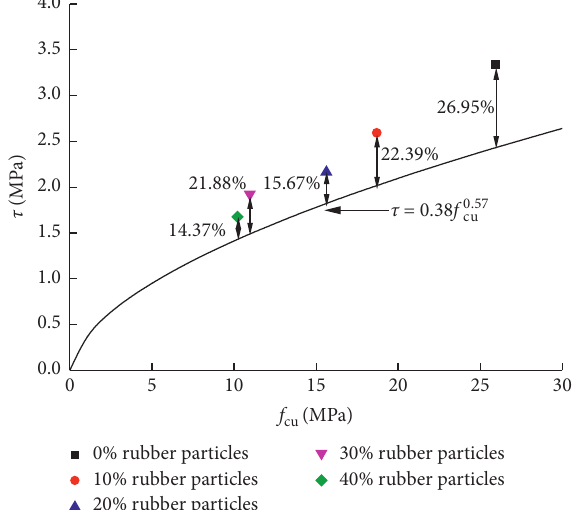
Figure 12: Relationship equation between the compressive strength and shear strength of concrete.